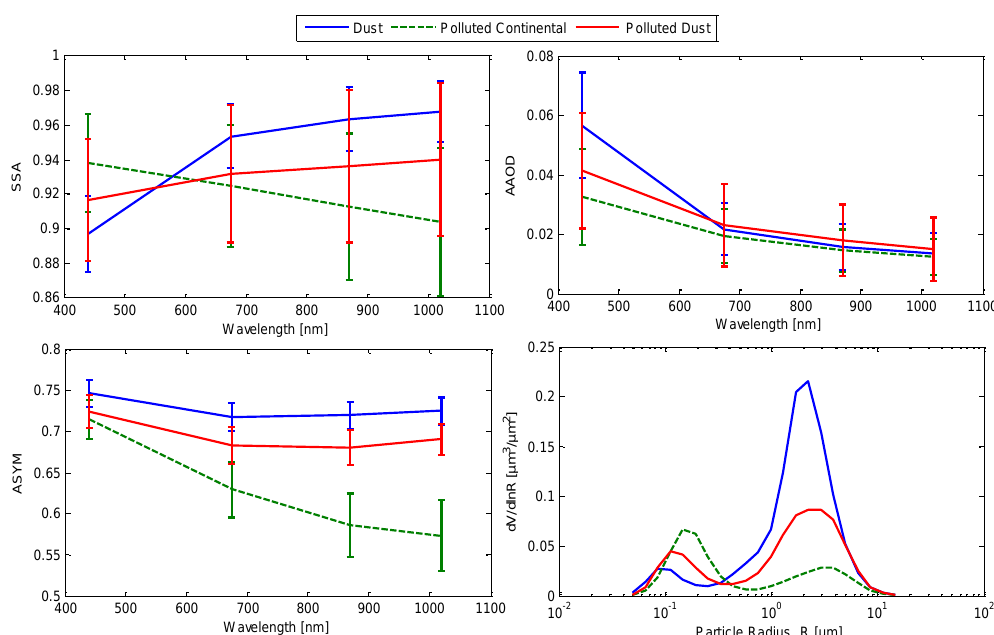
Figure 5. Spectral dependence of multi-year/multi-site average single scattering albedo (SSA), absorption aerosol optical depth (AAOD), asymmetry parameter (ASYM) and volume size distribution for dust, polluted dust and polluted continental over the Mediterranean basin. Total 259, 169 and 914 level 2 absorption data have been used to average for dust, polluted dust and polluted continental classes, respectively.